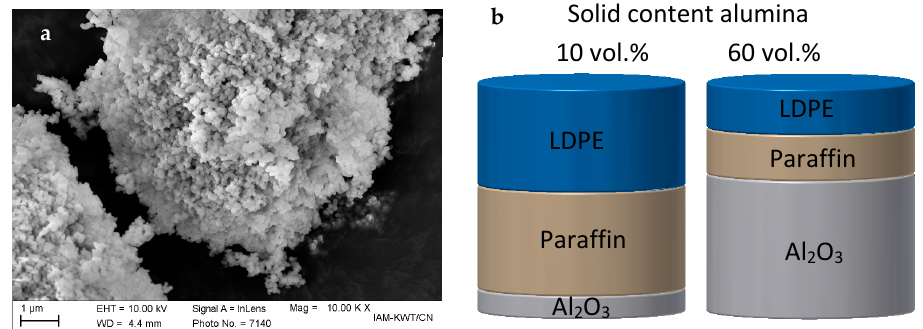
Figure 1. ( a ) SEM image of Al 2 O 3 ; ( b ) scheme of the feedstock composition exemplarily for 10 and 60 vol % alumina.